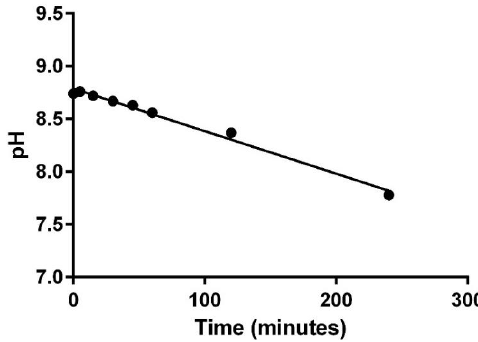
Figure 1. pH change for furosemide (1 mg/mL) with epinephrine (16 mcg/mL).